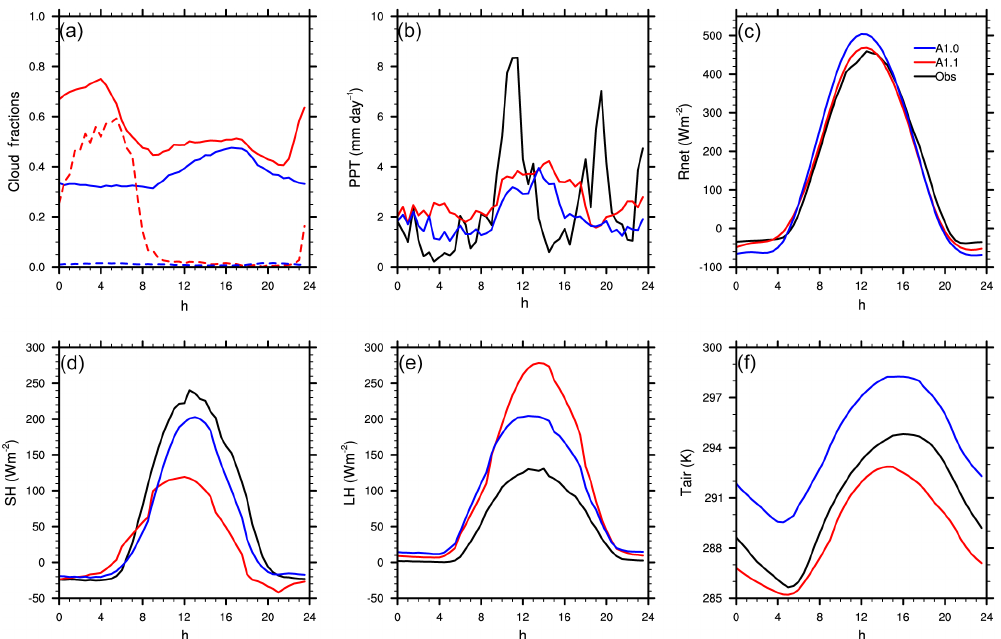
Figure 9. July diurnal cycles of (a) total cloud fraction (solid) and (1-year average only) very low cloud fraction (dash), (b) precipitation (PPT, mmday − 1 ), (c) net radiation (Rnet, Wm − 2 ), (d) sensible heat (SH, Wm − 2 ), (e) latent heat (LH, Wm − 2 ), and (f) screen/air temperature (Tair, K) for Boreas. Observations in black, ACCESS1.0 in blue, and ACCESS1.1 in